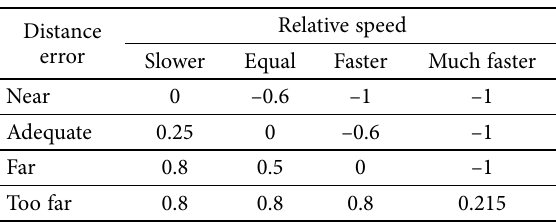
Fig. 3. Membership functions for CACC controller inputs Table. Initial singleton